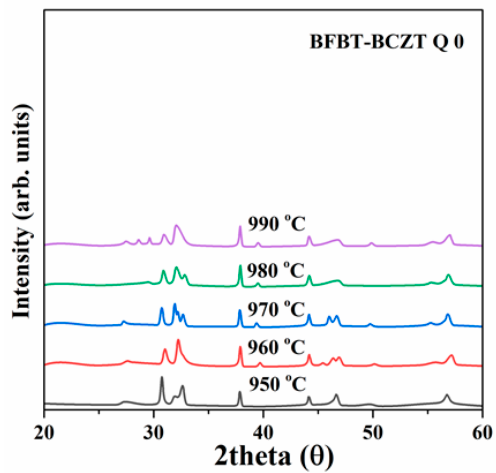
Figure 1. X–ray diffraction patterns for BFBT–zBCZT (z = 0.00) ceramics in the 2 θ ranges of 20–60° sintered at different temperatures.